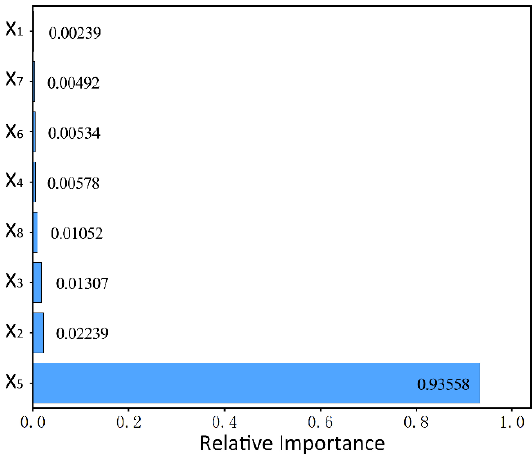
Figure 10. Figure 10. Feature-importance.